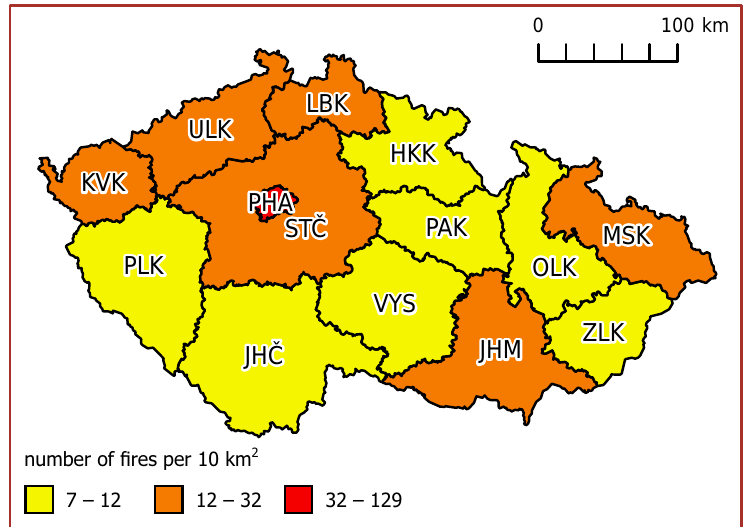
Figure 8. Spatial distribution of wildland fires per 10 km 2 in the regions of the Czech Republic. Data refer to the period